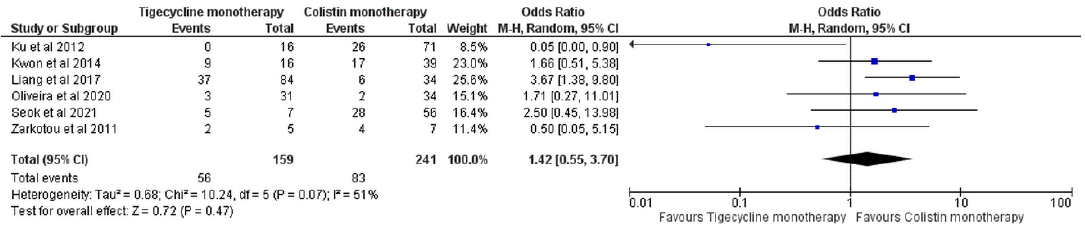
Figure 5. In-hospital mortality of tigecycline monotherapy versus colistin monotherapy [12,15–17,19,23].